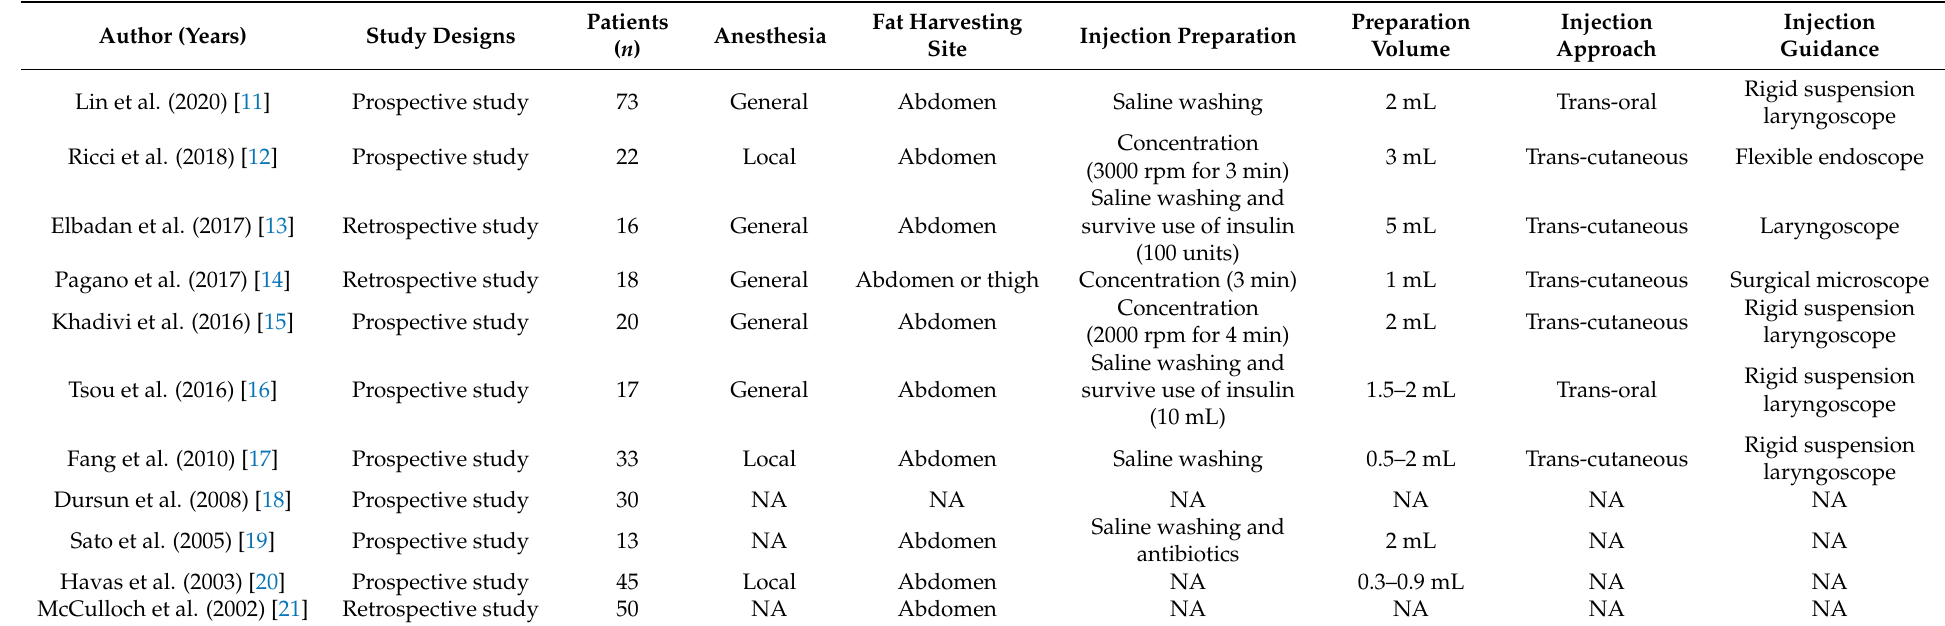
Table 1. Summary of the characteristics in 11 included